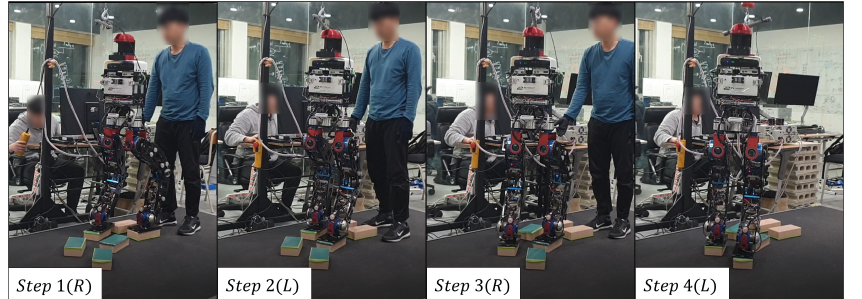
Figure 21. The experiment of Scene 3.